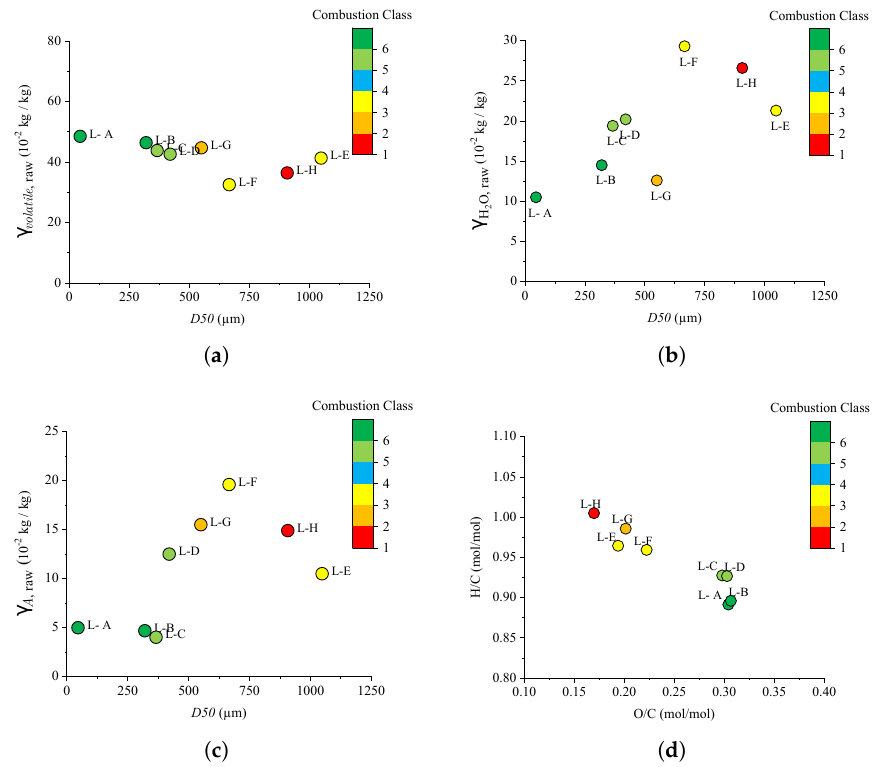
Figure 7. ( a ) fuel volatile share in the raw state, ( b ) fuel moisture content in the raw state, ( c ) fuel ash content in the raw state vs. median particle size of the samples sieved below 2 mm, ( d ) molar O/H/C diagram; “L” stands for Lignite (L-A: Lignite A), the color of each point represents the highest Combustion Class obtained by the 4 kW plasma jet within the tested experimental